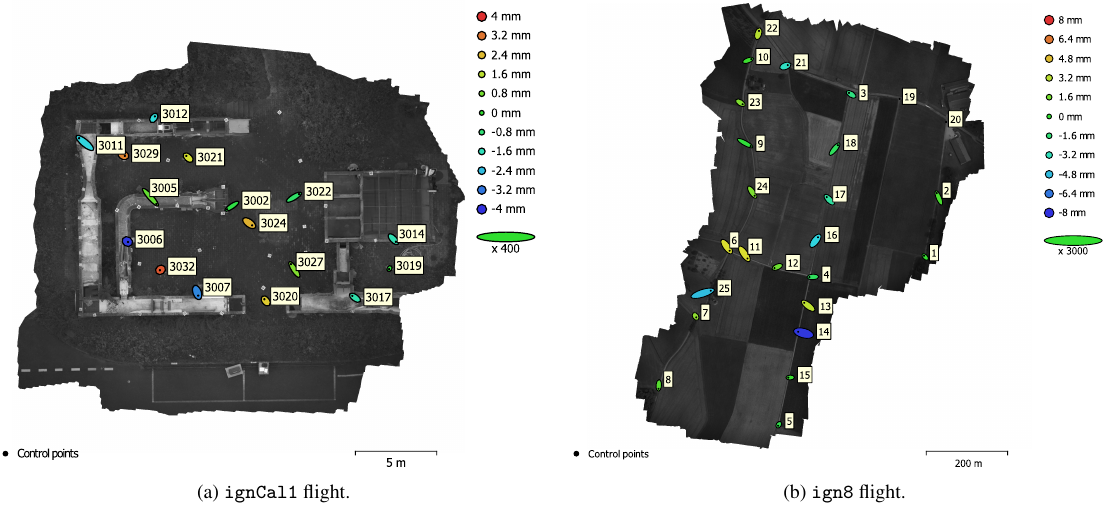
Figure 5. GCP residuals for two calibration flights.